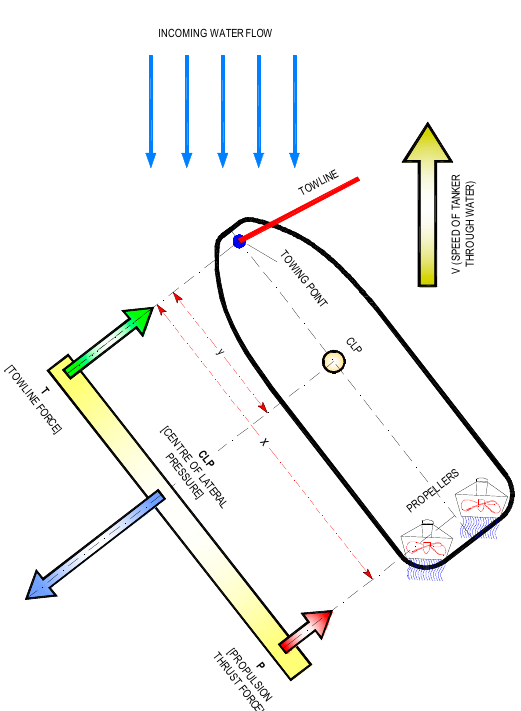
Figure 2. The athwartships force balance of an ASD escort tug using the pure indirect method. Drawing: Authors.